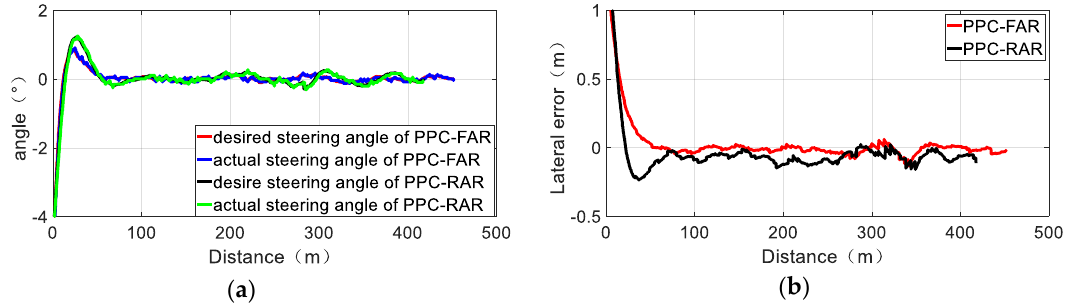
Figure 20. Lane-keeping experiment in a real driverless bus with PPC-FAR and PPC-RAR. ( a ) Steering